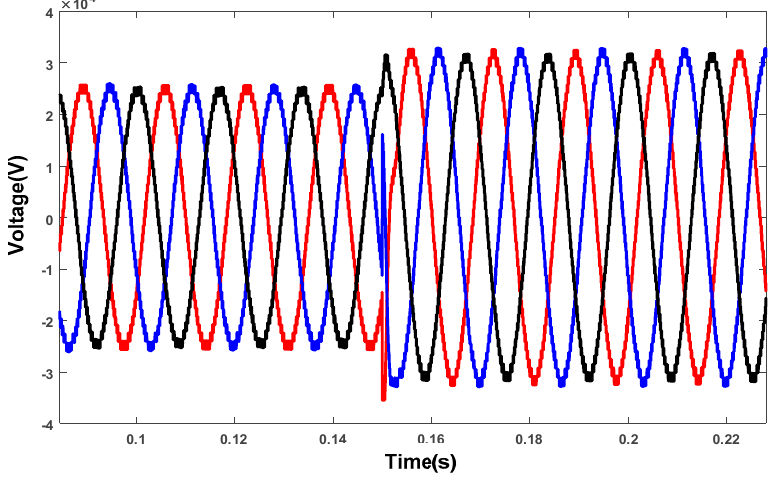
Figure 20. Phase voltage converters.